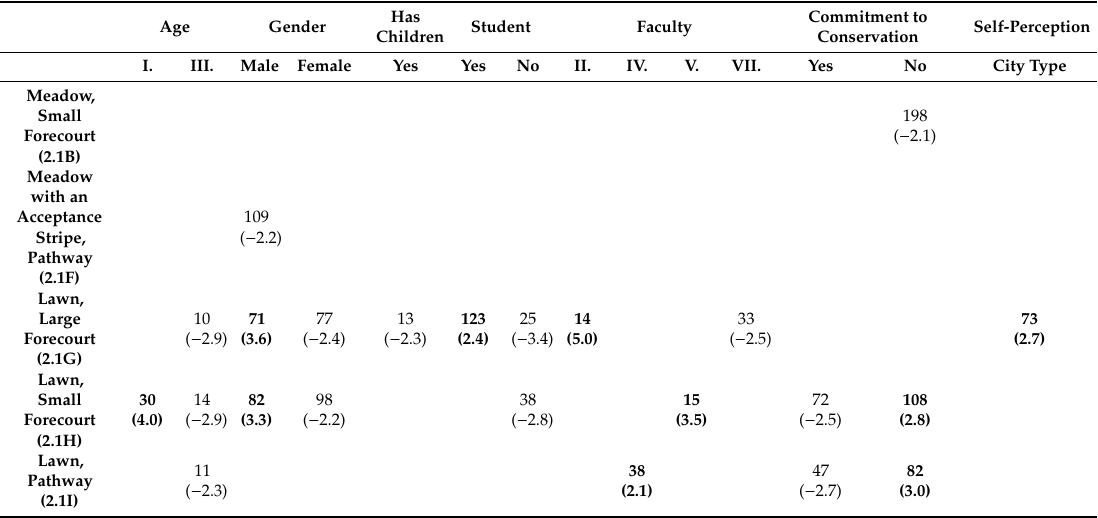
Table 3. Question 2.1 compared natural early summer meadows (2.1B and 2.1F) with lawns (2.1G, 2.1H, and 2.1I). The meadows were illustrated with (2.1F) and without (2.1B) an acceptance stripe. All green spaces were presented with variation in the degree of overgrowth: large forecourt (2.1G); small forecourt (2.1B and 2.1H); with a pathway (2.1F and 2.1I). The table presents the number of choices for a certain green space by the respective sociodemographic group (standardized residuals in brackets). Whereas a positive residual indicates that the scenario was appreciated by the relevant demographic group (bold type), a negative residual indicates that the scenario was disliked (normal typeface). Only significant cases are